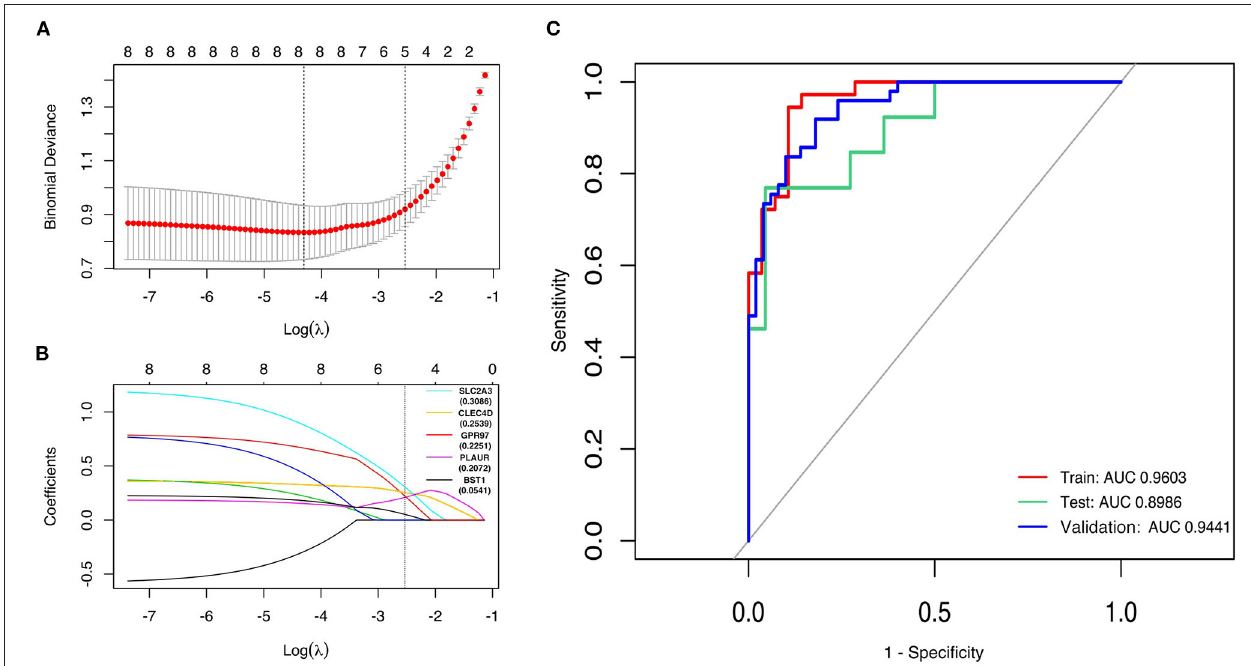
FIGURE 5 | Construction of LASSO regression model and ROC curves of hub genes. (A) The plot indicates binomial deviance of different numbers of variables revealed by the LASSO regression model for GSE66360. The red dots represent the value of binomial deviance; the gray lines represent the standard error (SE); the vertical dotted lines represent optimal values by the minimum criteria and 1-SE criteria. “Lambda” is the tuning parameter. (B) The plot determines the coefficient by 1-SE criteria of LASSO regression model 0.3086, 0.2593, 0.2251, 0.2072, and 0.0541 for SLC2A3 , CLEC4D , GPR97 , PLAUR , and BST1 , respectively. (C) The ROC curves of the LASSO regression model of training, testing, and 5-fold cross-validation in